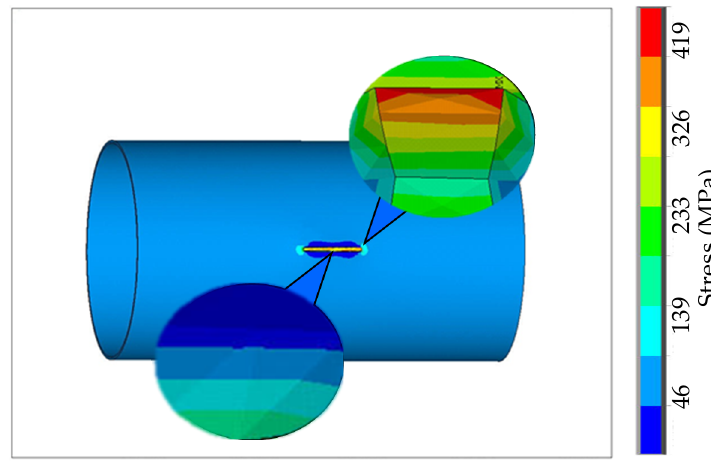
Figure 3. The stress diagram of pipeline crack.